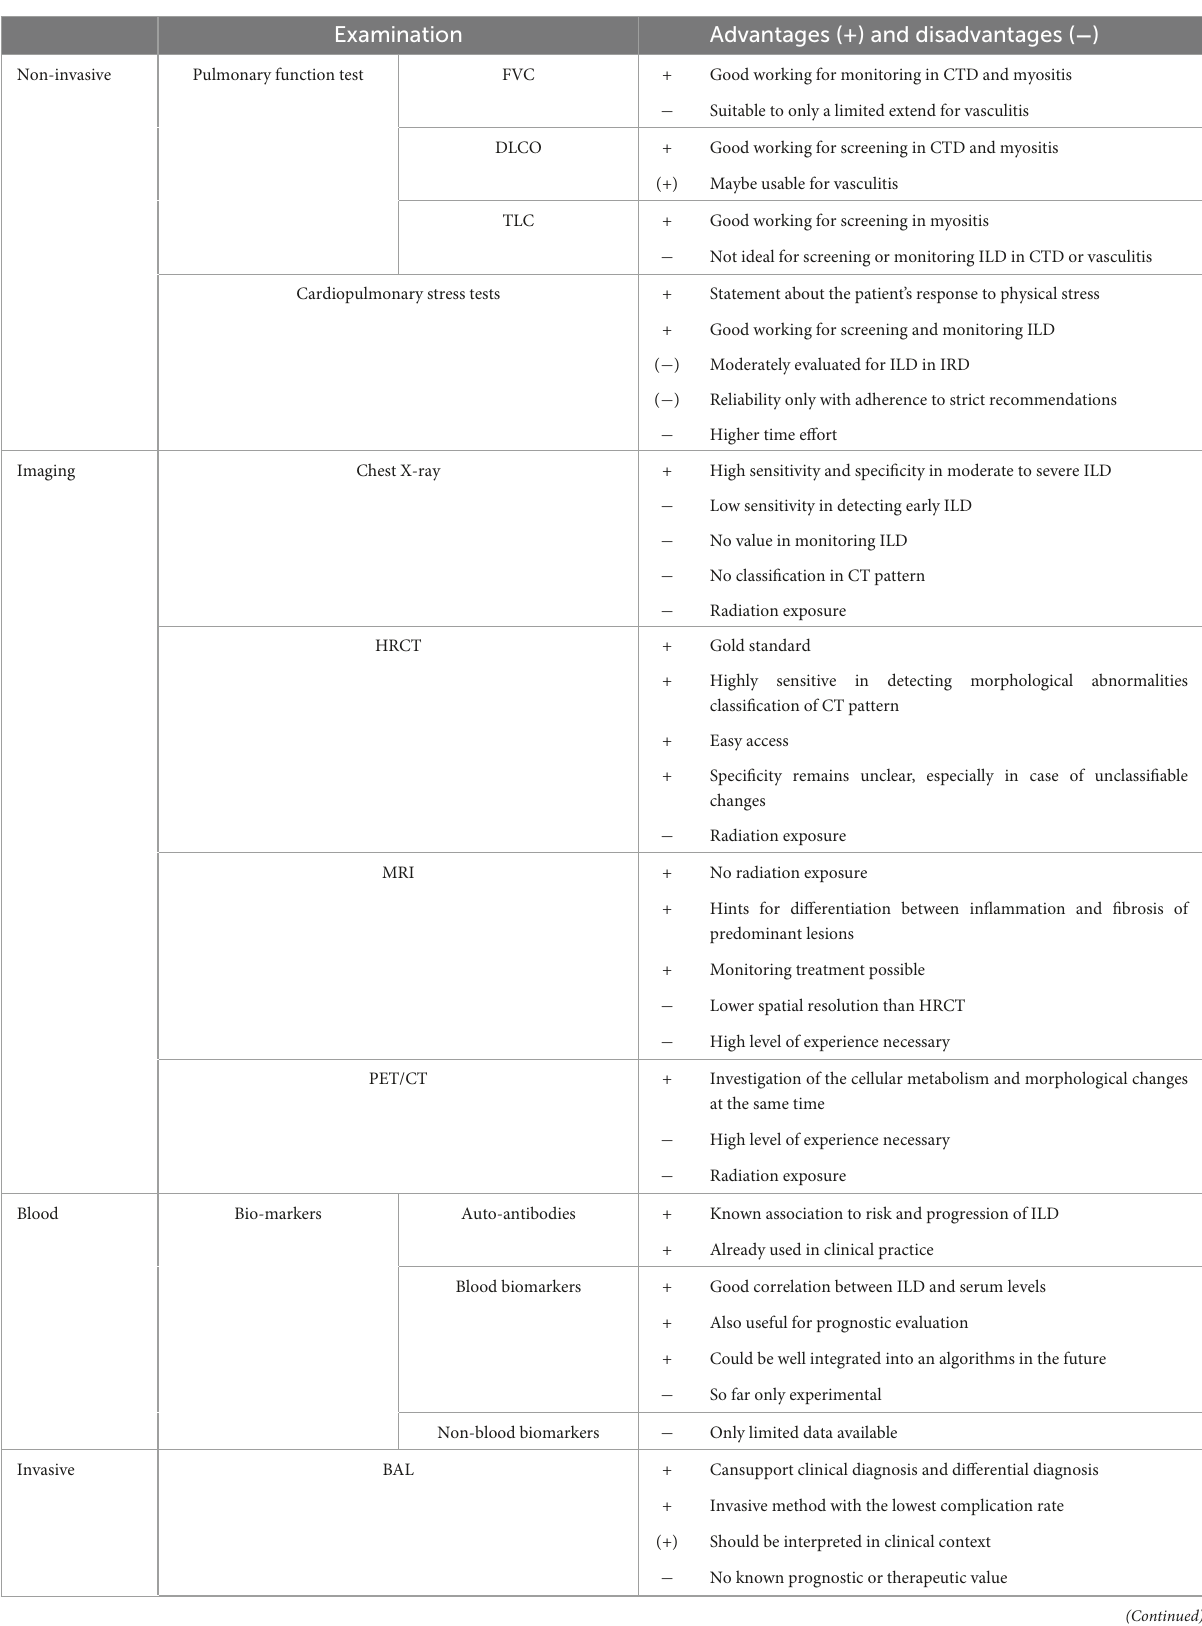
TABLE 1 Advantages and disadvantages of different methods in diagnosing ILD in IRD-patients.